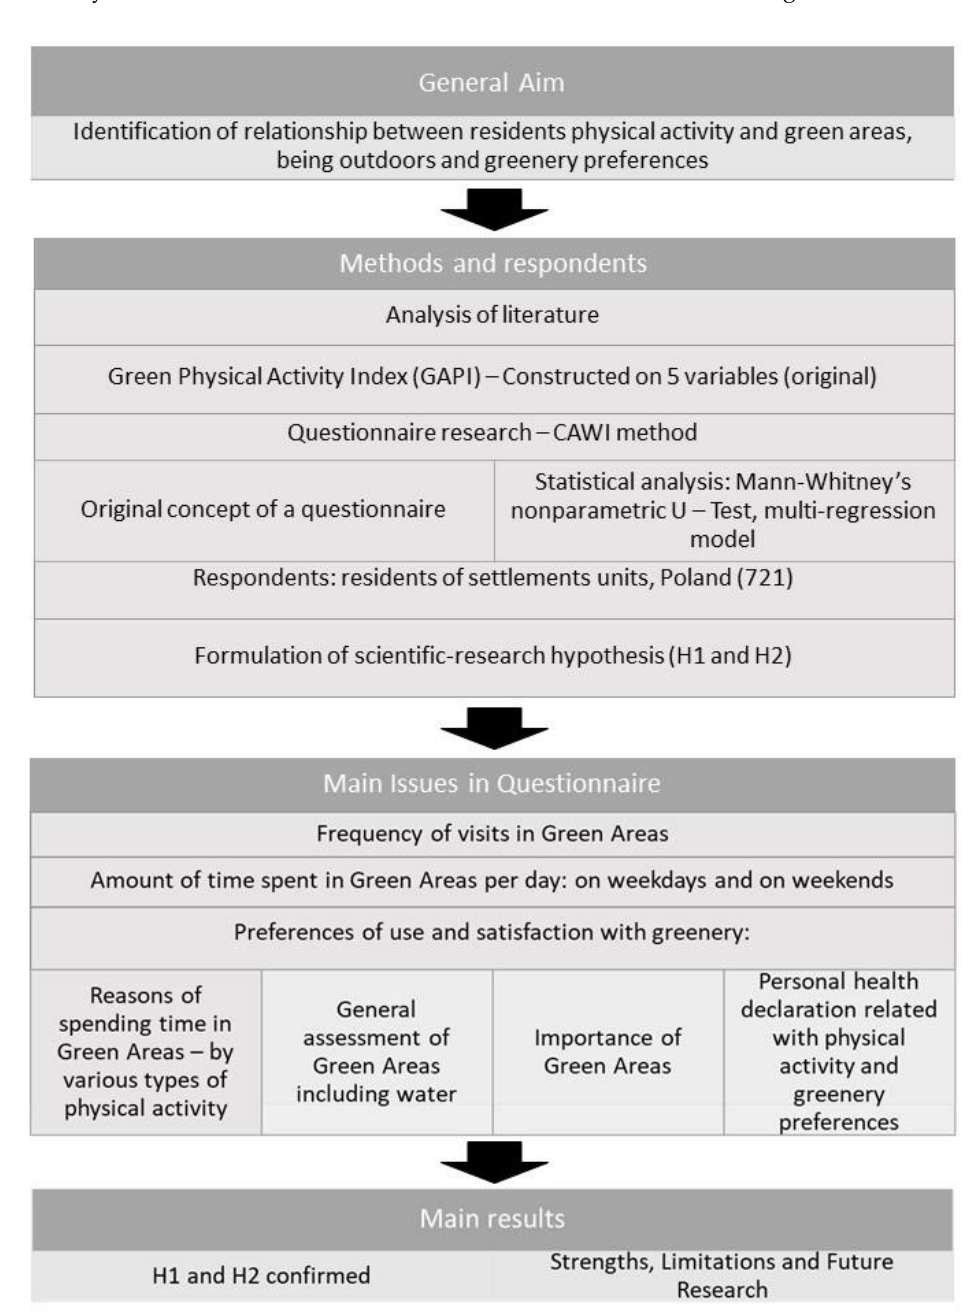
Figure 1. Framework of the study.